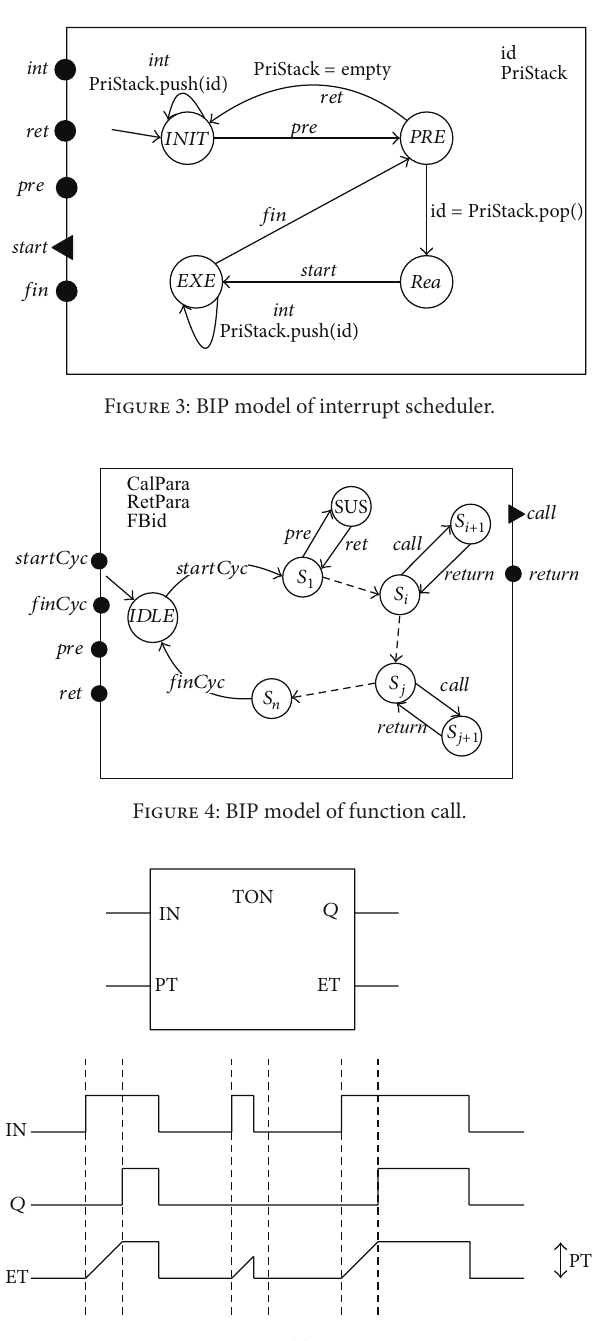
Figure 5: TON timer.